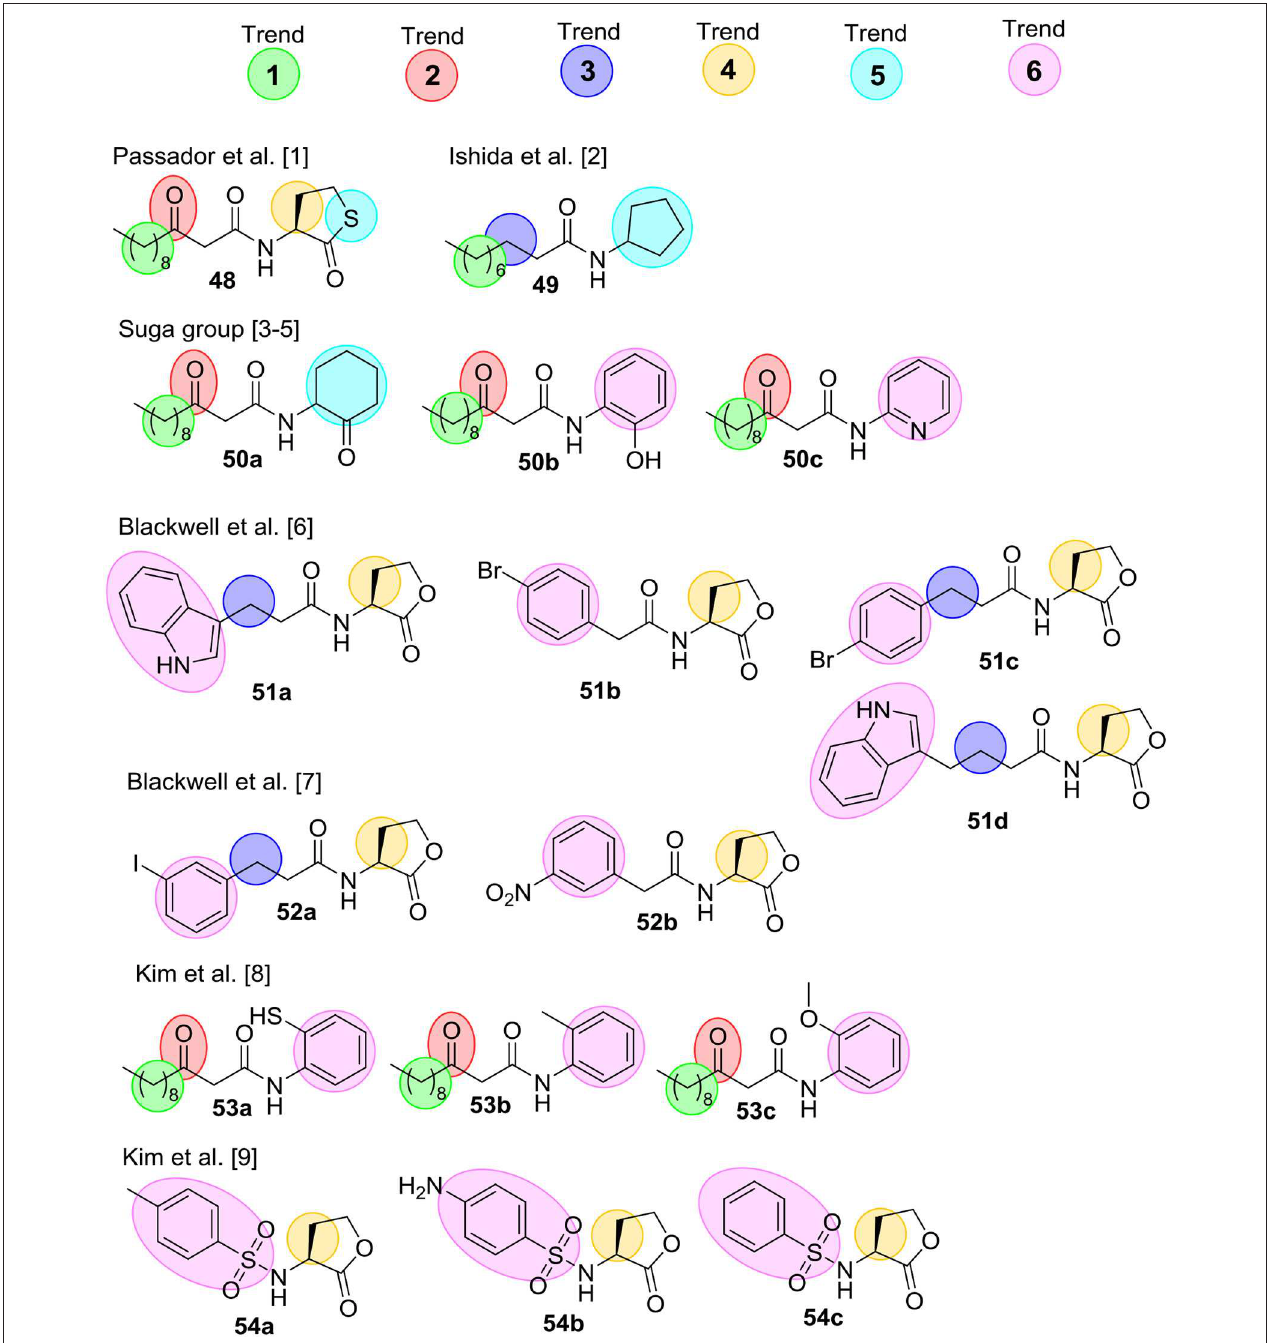
FIGURE 14 | Collection of the most potential QS inhibitors mentioned in Geske et al. (2008b) and Galloway et al. (2011). [1] (Passador et al., 1996) [2] (Ishida et al., 2007) [3] (Smith et al., 2003a) [4] (Smith et al., 2003b) [5] (Jog et al., 2006) [6] (Geske et al., 2005) [7] (Geske et al., 2008a) [8] (Kim et al., 2009a), and [9] (Kim et al., 2009b).